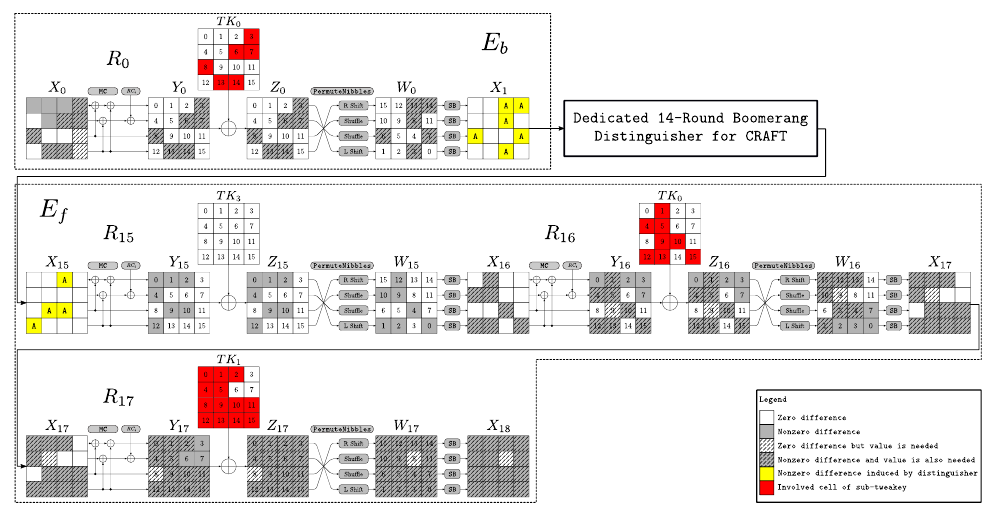
Figure 16: A 18-round key recovery attack against